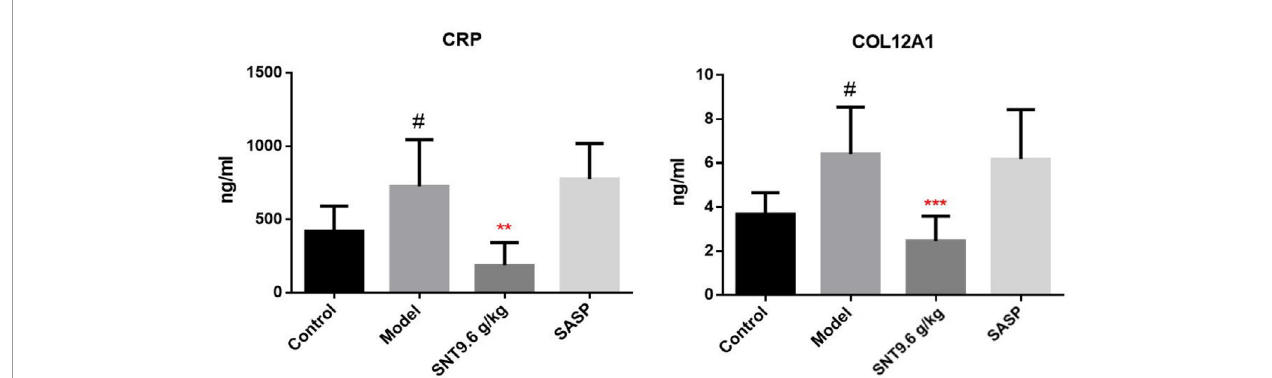
FIGURE 4 | Veri fi cation of the SNT-regulated signature proteins (CRP and COL12A1) that may indicate the ef fi cacy of SNT against UC in rats. Serum CRP and COL12A1 levels were quanti fi ed by enzyme-linked immunosorbent assays (ELISAs). # P < 0.05 vs control group; ** P < 0.01 and *** P < 0.001 vs model group.